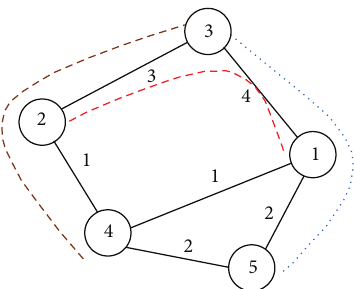
Figure 4: A single path for each demand.